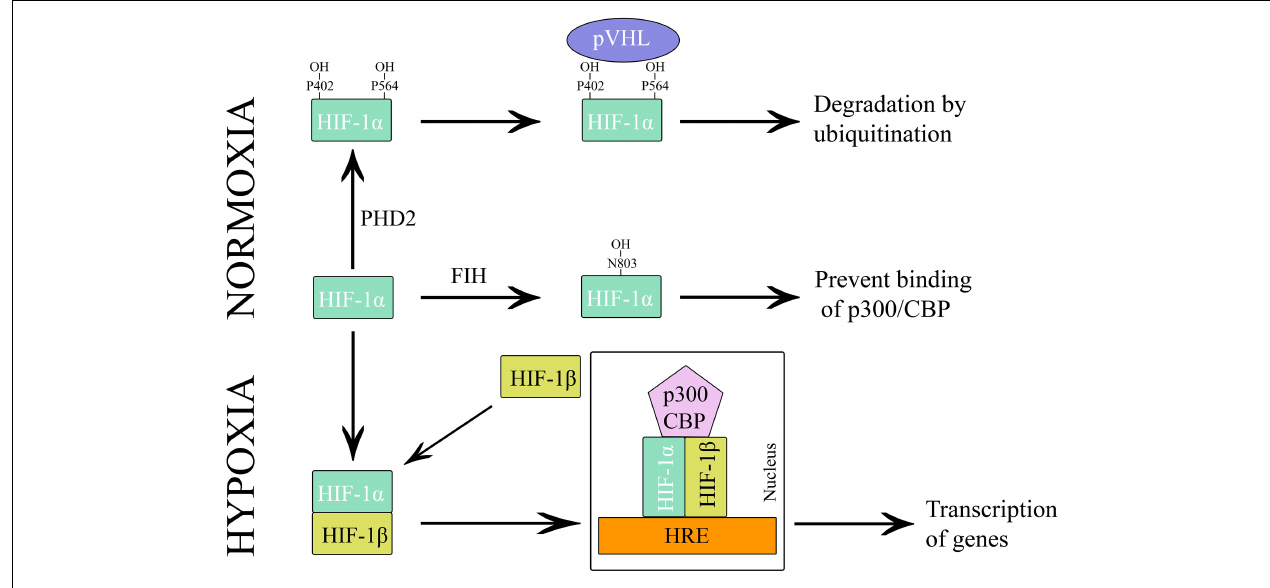
FIGURE 3 | Regulation of HIF-1 during hypoxia and